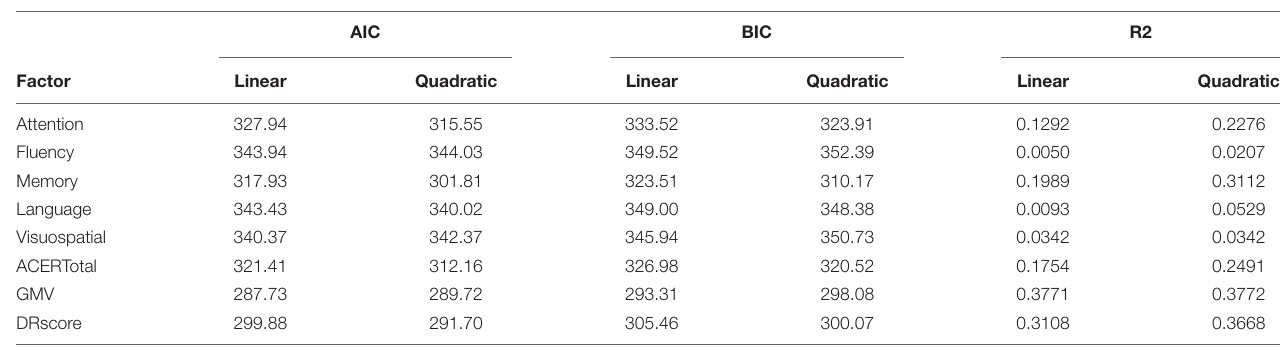
TABLE 3 | A summary of AIC, BIC, and R2 values for the two regression models of each factor.